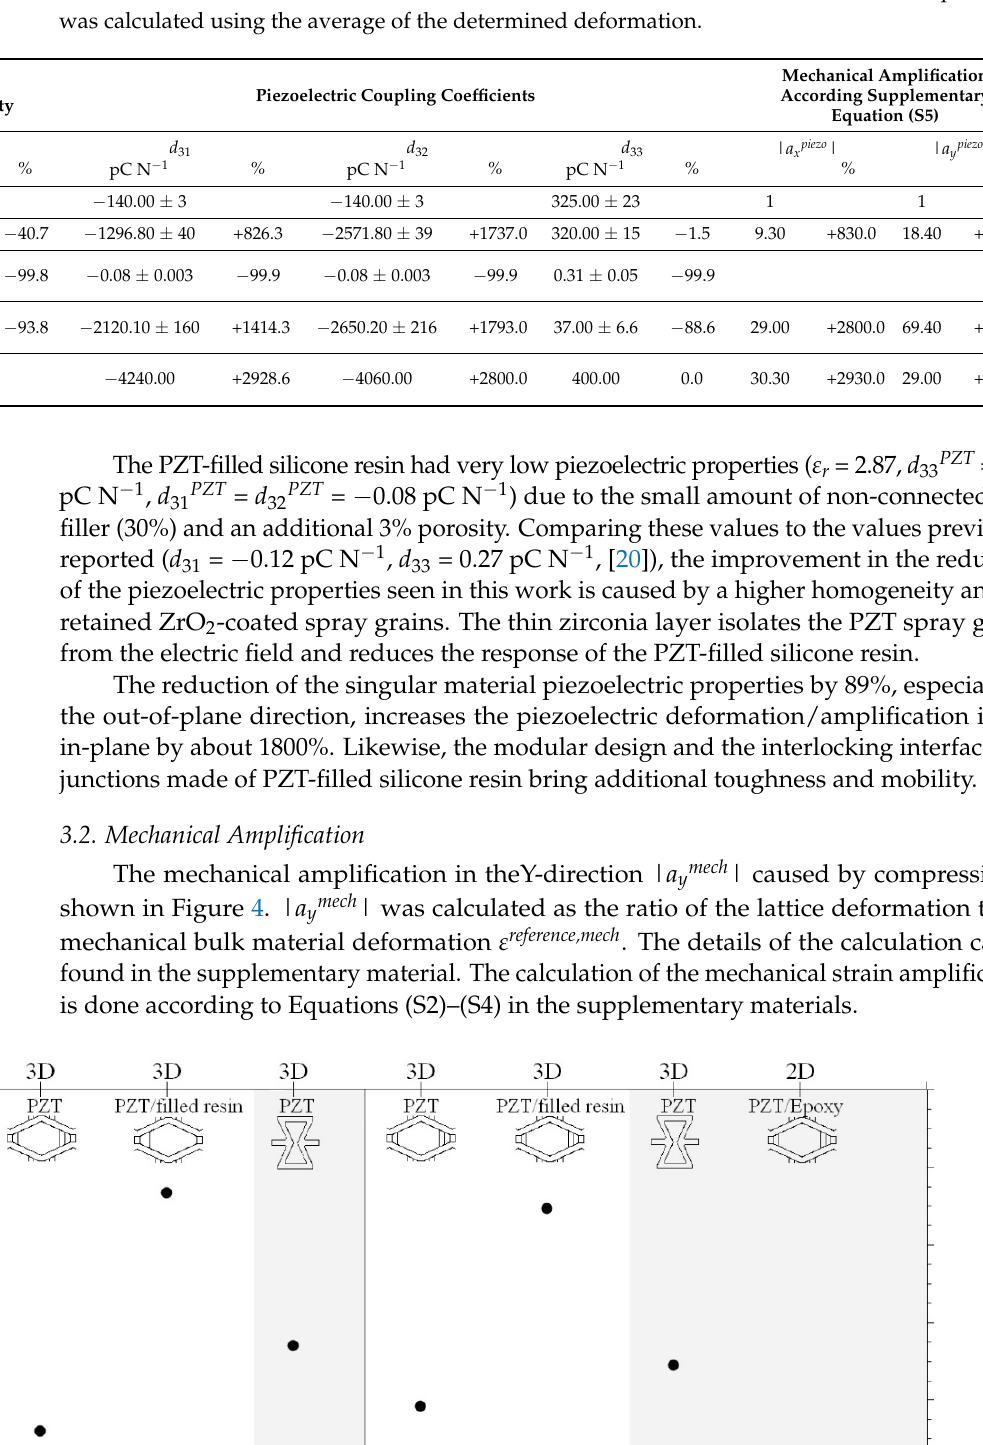
Table 2. Piezoelectric coupling coefficients of bulk PZT, PZT lattices, PZT-filled silicone resin, compos-